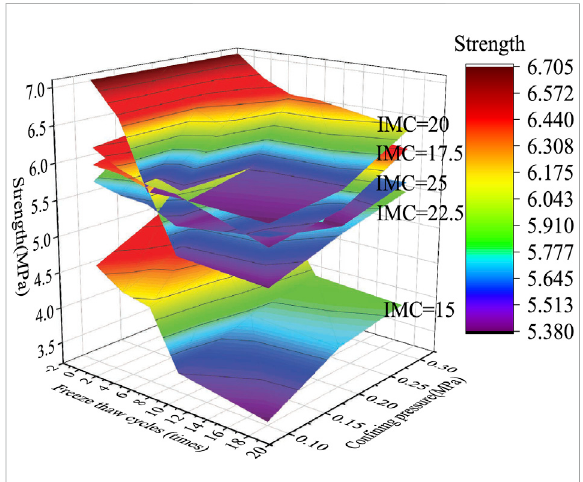
FIGURE 12 Three dimensional changes of freeze-thaw cycles, con fi ning pressure and strength under different initial moisture